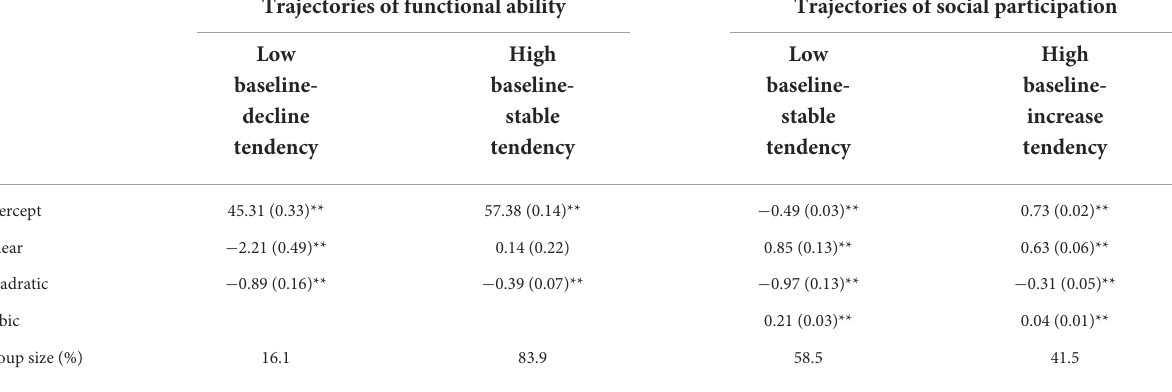
TABLE 2 Maximum likelihood parameter estimates for trajectories functional ability and social participation (standard errors in